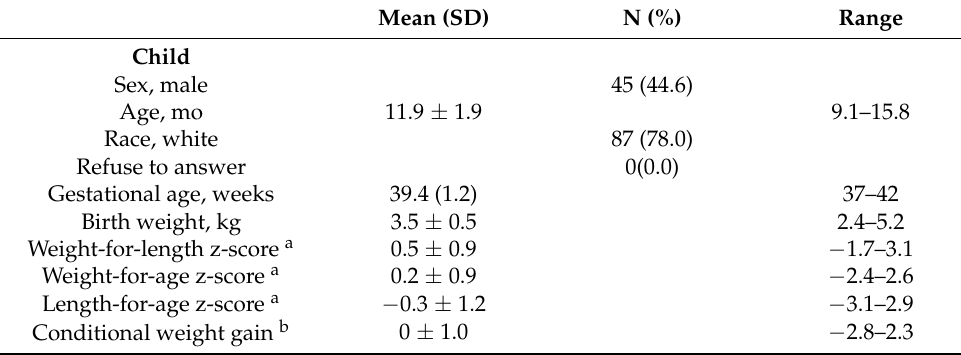
Table 1. Participant characteristics ( n =